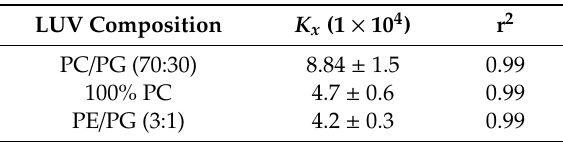
Figure 6. Binding isotherms for Trematocine interacting with LUVs of different compositions. Table 2. Stern–Volmer constant relative to Trematocine in the presence / absence of LUVs of di ff erent Tryptophan fluorescence was measured. Trematocine concentration was 1 µM. compositions. Net Accessibility Factor (NAF) is defined as in Equation (2). Table 2. Stern–Volmer constant relative to Trematocine in the presence/absence of LUVs of different compositions. Net Accessibility Factor (NAF) is defined as in Equation (2).